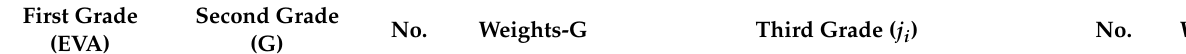
Table 3. Weights of six groups variables and twenty-two indicators used for EVA of Punjab